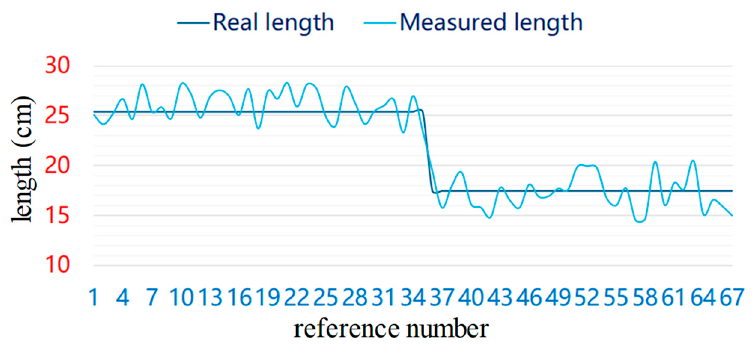
Figure 15. Yarn roll’s length measurement error.